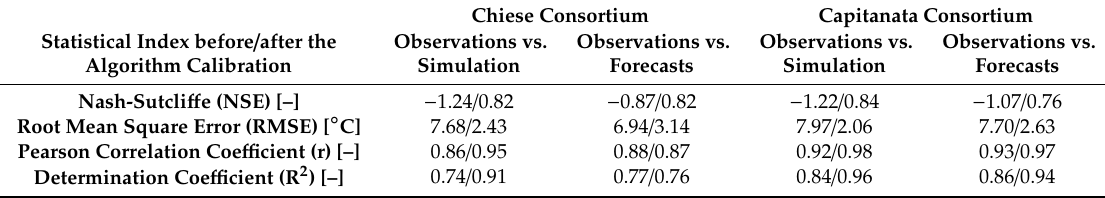
Table 11. Statistical indexes obtained before and after the calibration of the β coefficient.